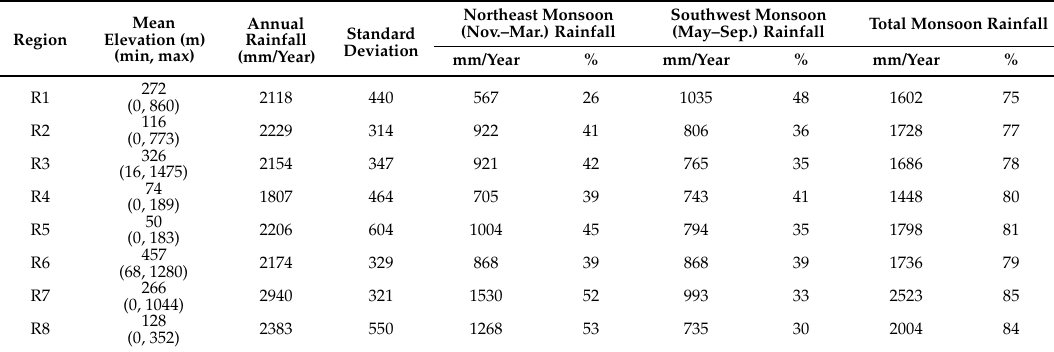
Table 2. Rainfall contributions in Peninsular Malaysia for the period of 1976–2006. Northeast Monsoon Mean Annual (Nov.–Mar.) Standard Elevation (m) Region Rainfall Deviation (min, max) (mm/Year)